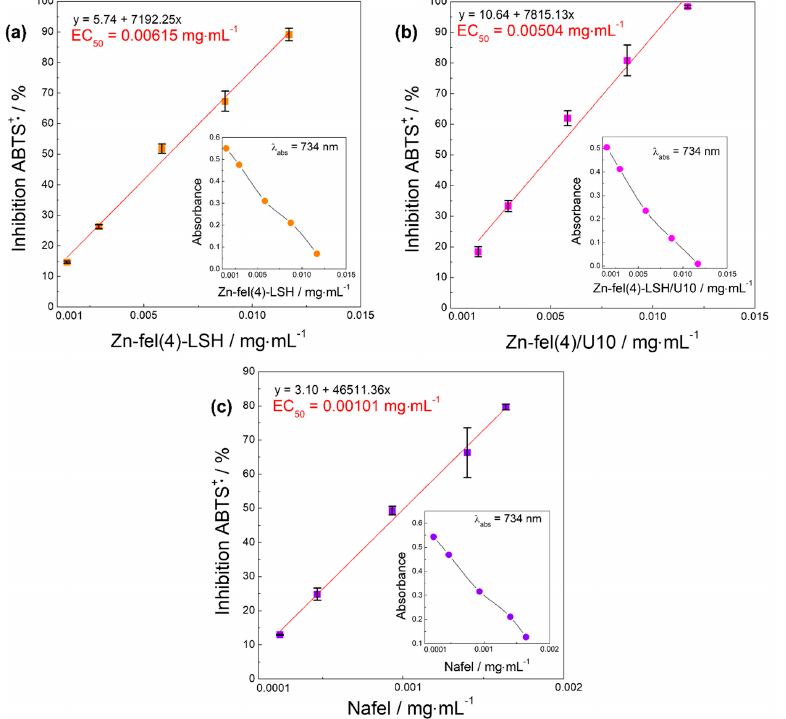
Figure 12. Inhibition (capture) of ABTS •+ radicals by ( a ) Zn-fel(4)-LSH, ( b ) Zn-fel(4)-LSH/U10, and ( c ) Nafel (NaC 10 H 9 O 4 ) samples. Figures inserted show average absorbance of ABTS •+ species as function of the sample concentration. Hypochlorous acid (HOCl) is a non-radical reactive species, which has strong anti- microbial activity in the human organism [62]. However, high reactivity of the HOCl com- bined to propensity to permeate membranes can oxidize biomolecules causing cellular damages [62]. In the hypochlorous acid scavenging assay, the antioxidant compound in- teracts with HOCl/OCl − species and prevents the formation of the blue chromophore com- pound produced by oxidation of the TMB [63]. Thus, the intensity decrease of the absorp- tion band of blue chromophore at 655 nm is proportional to the increase of the antioxidant concentration. Based on the results of this assay (Figure 13), it is noted that LSH-ferulate materials and Nafel salt have HOCl/OCl − inhibiting capacity and the increasing order in efficiency for capturing HOCl/OCl − species is Zn-fel(4)-LSH/U10 (EC 50 = 0.00319 mg mL − 1 ) < Zn-fel(4)-LSH (EC 50 = 0.00297 mg mL − 1 ) < Nafel (EC 50 = 0.000827 mg mL − 1 ). Therefore, LSH-ferulate materials and Nafel salt act as HOCl/OCl − sequestrants and can reduce tissue damages caused by attacks of microorganisms and inflammatory processes [57].